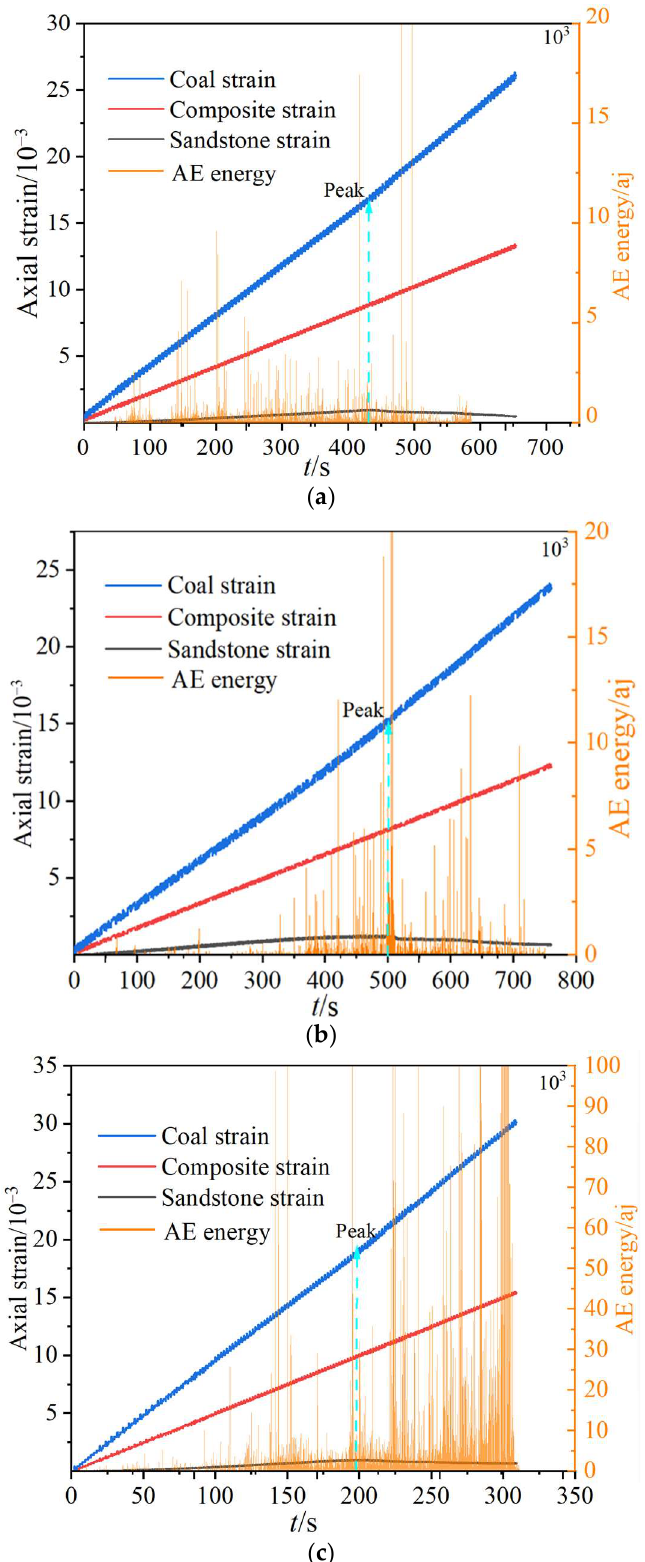
Figure 6. Strain relation between sandstone and coal stratification of specimens with different lith- ological coal rock combinations. ( a ) c oarse sandstone–coal; ( b ) siltstone–coal; ( c ) fine sandstone–coal.